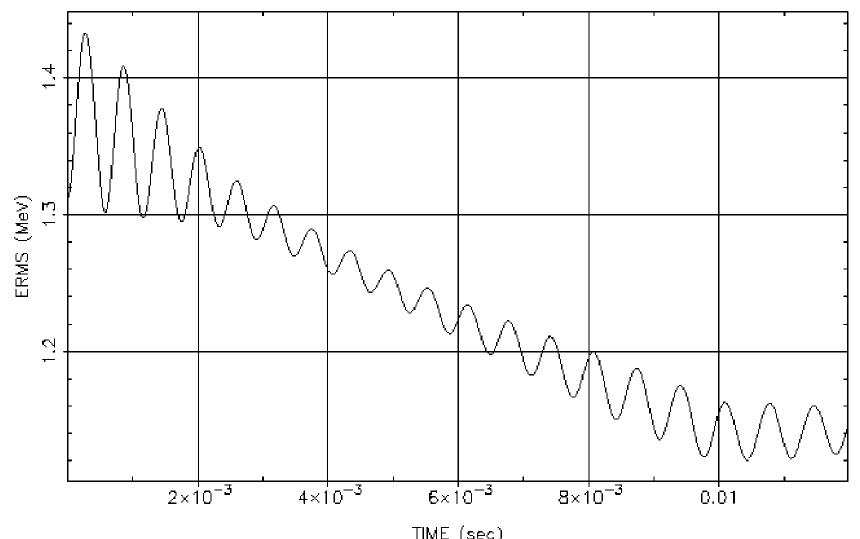
FIG. 3. The rms energy spread vs time in the ring specified in Table II for a beam intensity of 2 3 10 13 protons including both an h (cid:1) 3 HOM and the perfectly conducting wall space charge force.